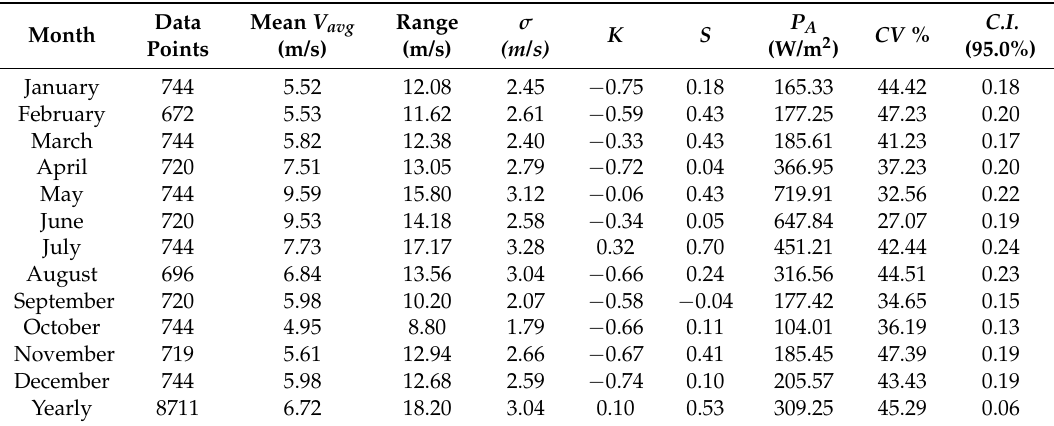
Table 2. Monthly and yearly descriptive statistics of the recorded wind speed data for Baburband wind masts, at 80 m height for the year 2010.